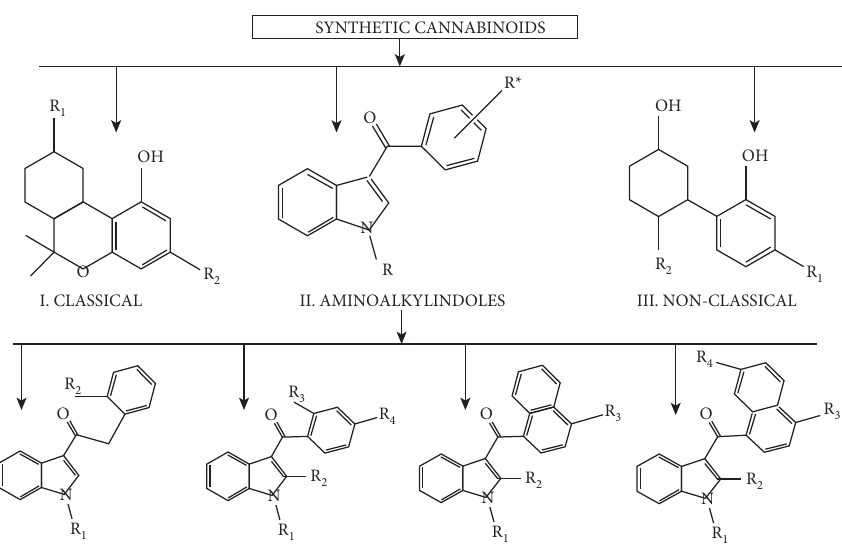
Figure 1: Synthetic Figure 4, together with the identification number from PubChem.